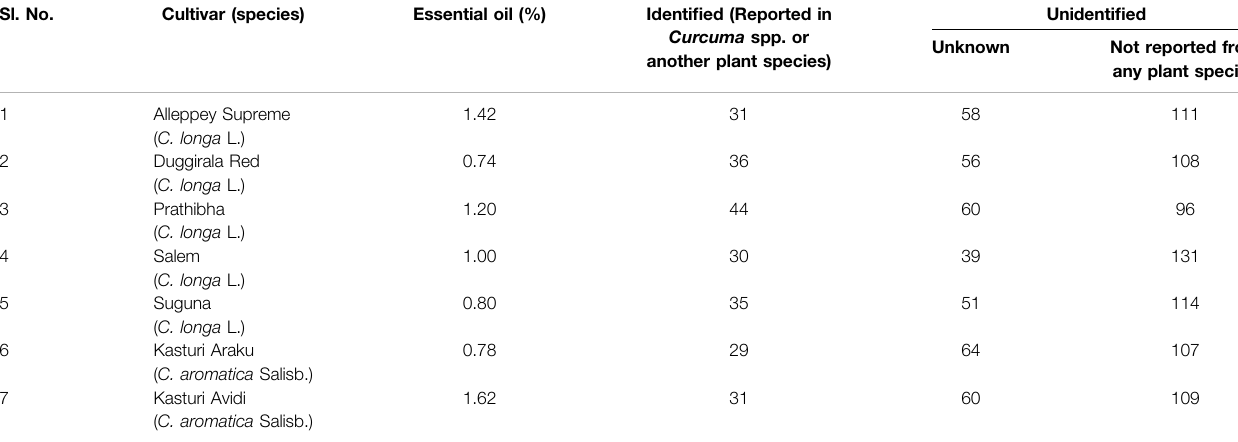
TABLE 1 | Essential oil content and total number of compounds detected by GC-MS in the rhizomes of Curcuma species. Sl.